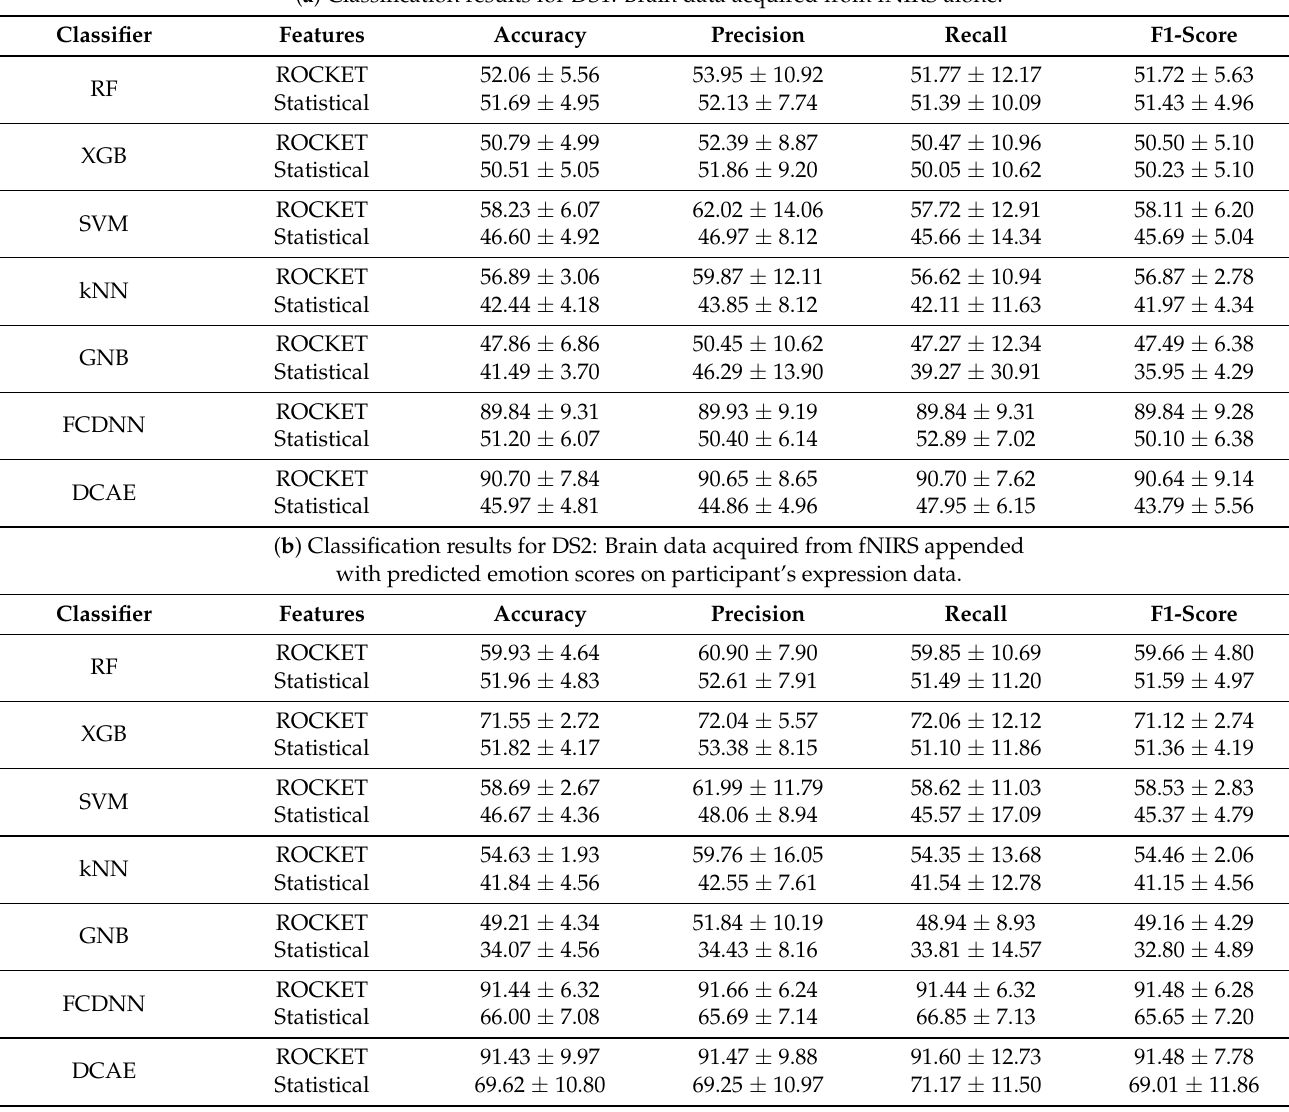
Table 3. Single-trial classification results for expertise levels of participant’s into NVs, ITs, and EXs ( a ) DS1 and ( b ) DS2 with ROCKET features or statistical features using various classification paradigms. ( a ) Classification results for DS1: Brain data acquired from fNIRS alone.